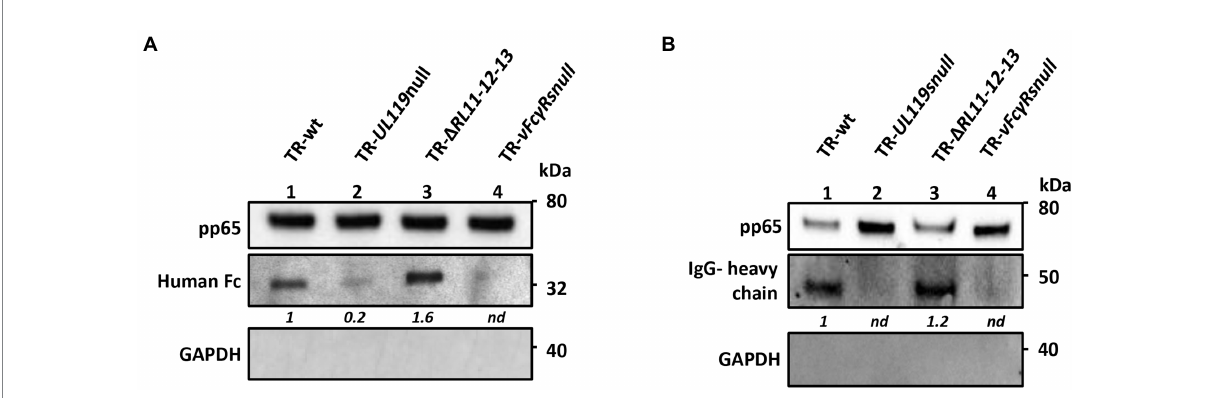
FIGURE 5 gp68 is the main protein responsible for transporting human Fc and IgGs on virions. HFF-1 cells were infected with HCMV TR-wt, TR- UL119 -null, TR- Δ RL11-12-13, and TR- vFc γ Rs -null mutant. 48 hpi, 6.6 μ g/ml of human Fc γ (A) or 13.2 μ g/ml of recombinant human IgGs (B) were added to the culture media. At day 4 pi medium was replaced with fresh DMEM 15% FBS and supernatant was collected at 6 dpi. Viral particles were purified through a sucrose cushion. Pelleted viruses were treated for SDS-PAGE and western blot analysis. Anti-human HRP-conjugated IgG antibody was used to reveal Fcs (A) and IgGs (B) . Anti-pp65 was used as markers of viral tegument. Anti-GAPDH was used to exclude cellular